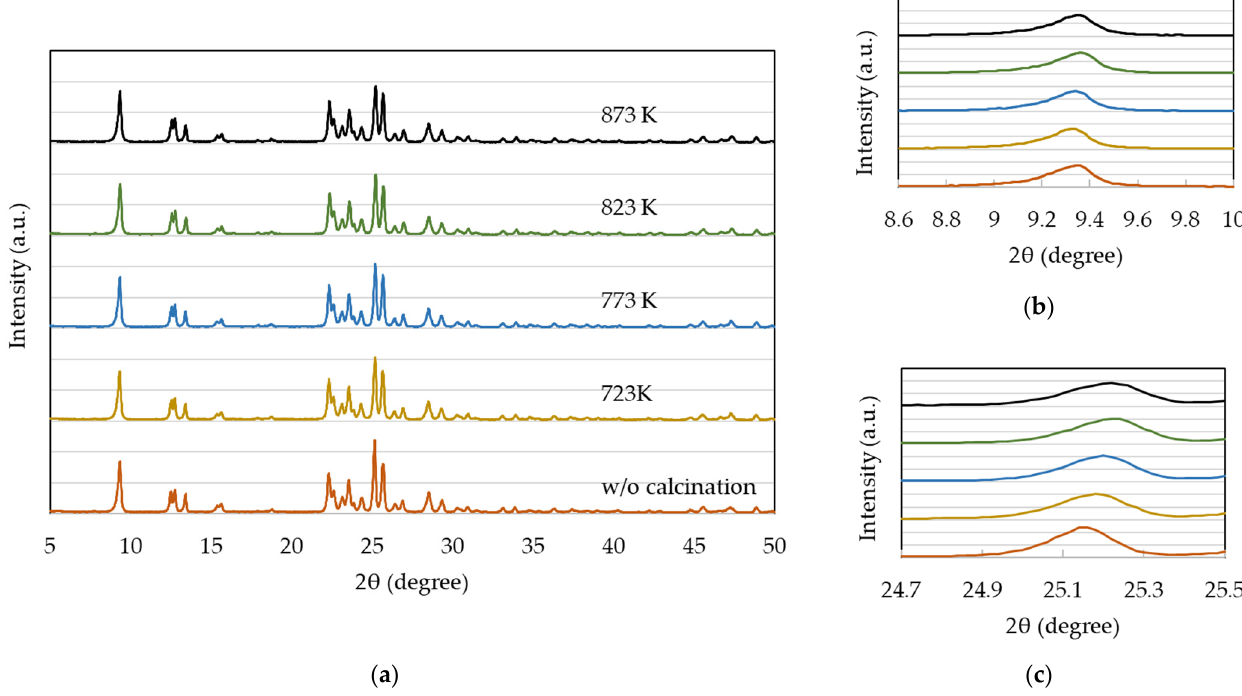
Figure 5. XRD patterns of 720NHA (FER) at different calcination temperatures: ( a ) 5–50°; ( b ) 8.6–10°; and ( c ) 24.7–25.5°.